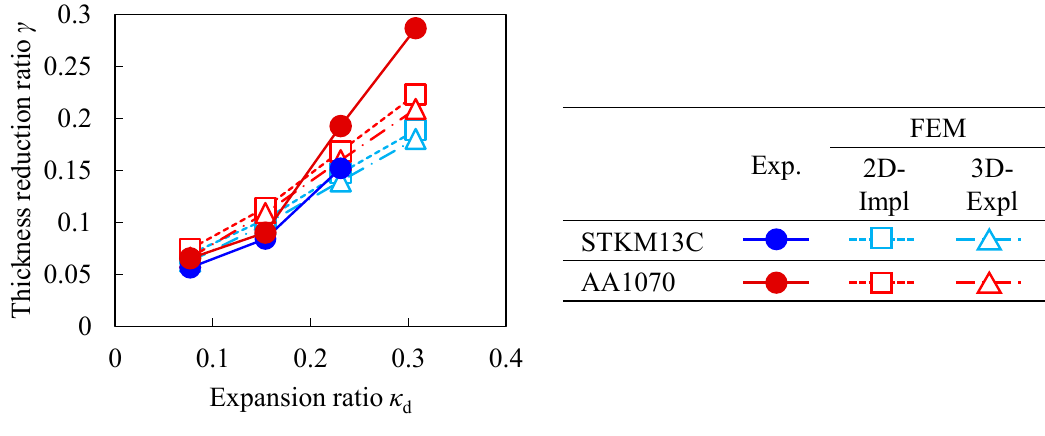
Figure 16. Effect of expansion ratio κ d on thickness reduction ratio γ . Figure 17. Effect of expansion ratio κ d on ovality ratio ω .